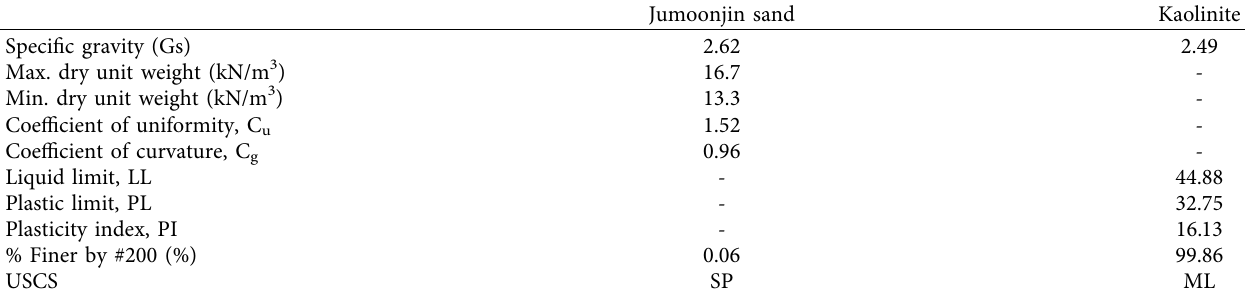
Table 1: Temperature and wildlife count in the three areas covered by the